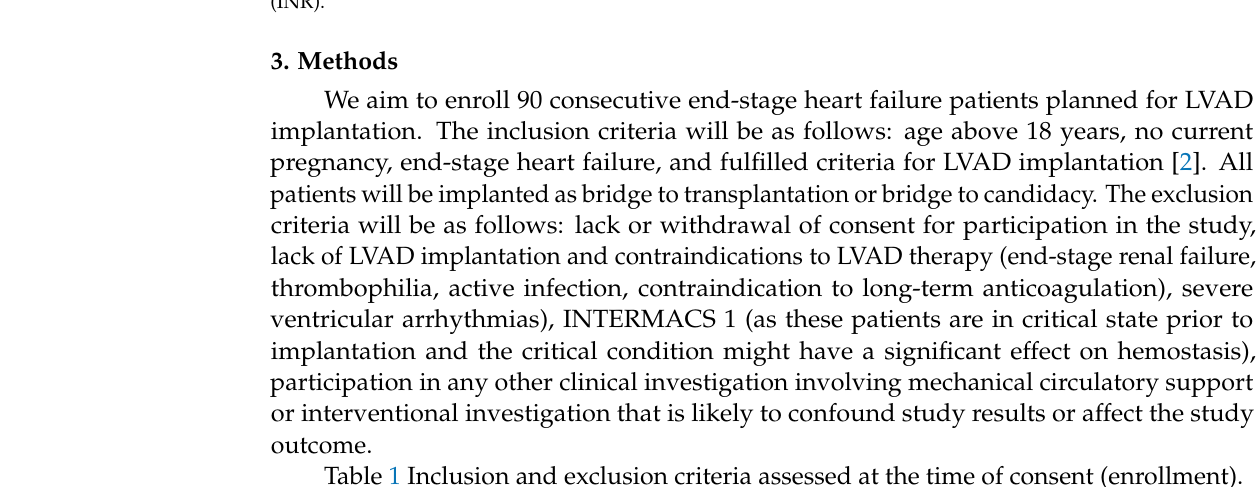
Table 1 Inclusion and exclusion criteria assessed at the time of consent